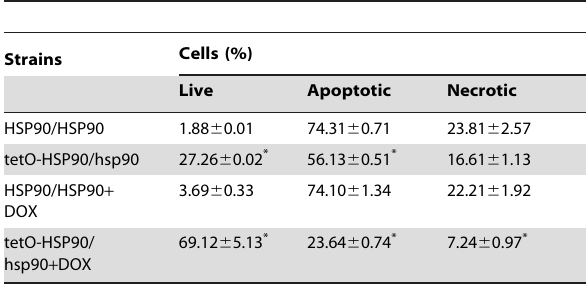
Table 1. The percentage of cells in C. albicans after H 2 O 2 treatment with or without DOX 1 . Table 2. The percentage of cells in C. albicans after AA treatment with or without DOX 2